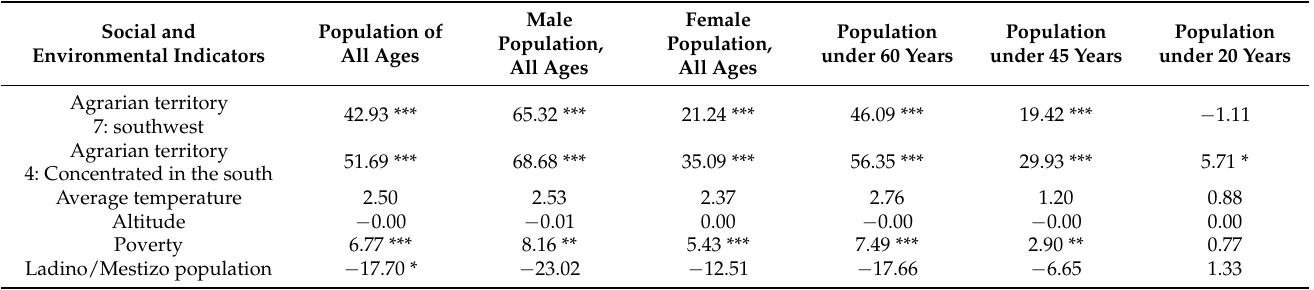
Table 6. Multivariate linear regression coefficients for significant social and environmental indicators and municipal mortality rates for chronic kidney disease, Guatemala 2009–2019 ( N =